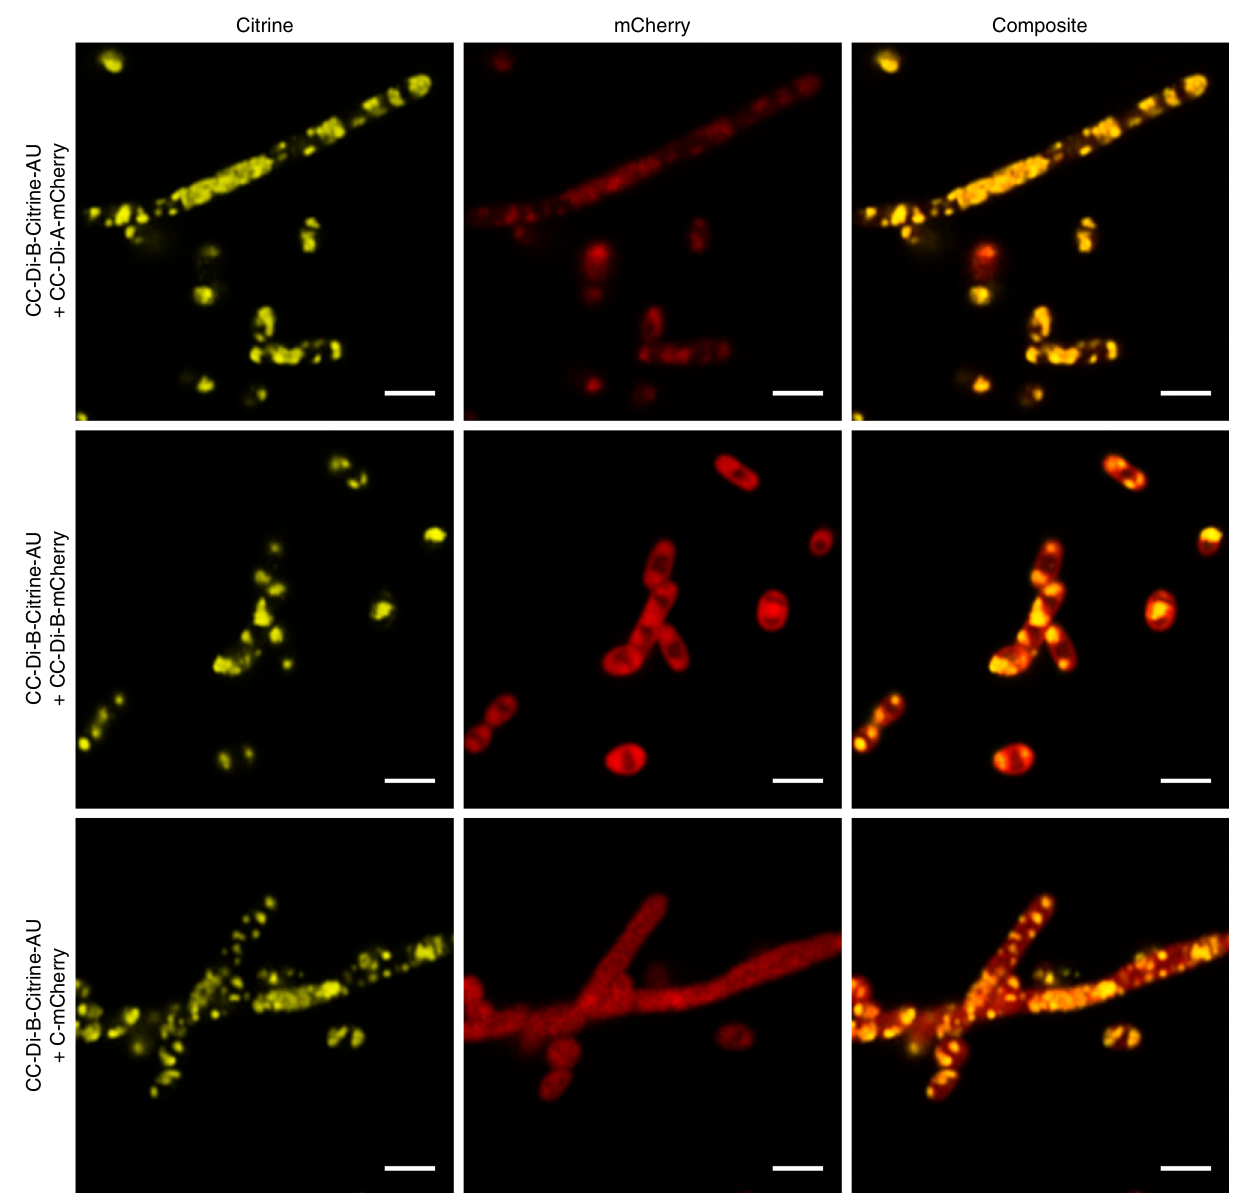
Fig. 3 Localization of fl uorescent proteins to coiled-coil labeled BMCs. Confocal analysis of E. coli BL21 * (DE3) cells showing Citrine, mCherry and composite fl uorescence signals for cells expressing CC-Di-B-Citrine-PduA-U with CC-Di-A-mCherry, CC-Di-B-mCherry or C-mCherry. Scale bars show 2 µ